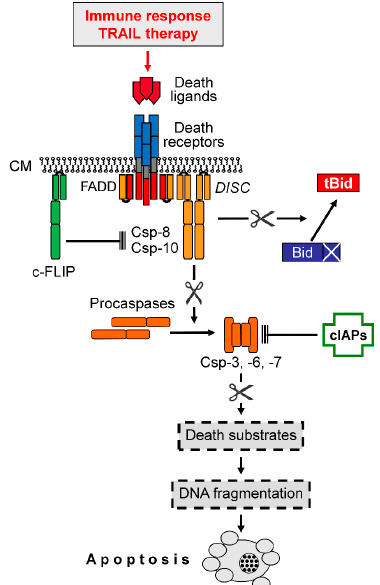
Figure 2. Extrinsic proapoptotic signaling. Binding of death ligands (e.g., TRAIL) to cognate